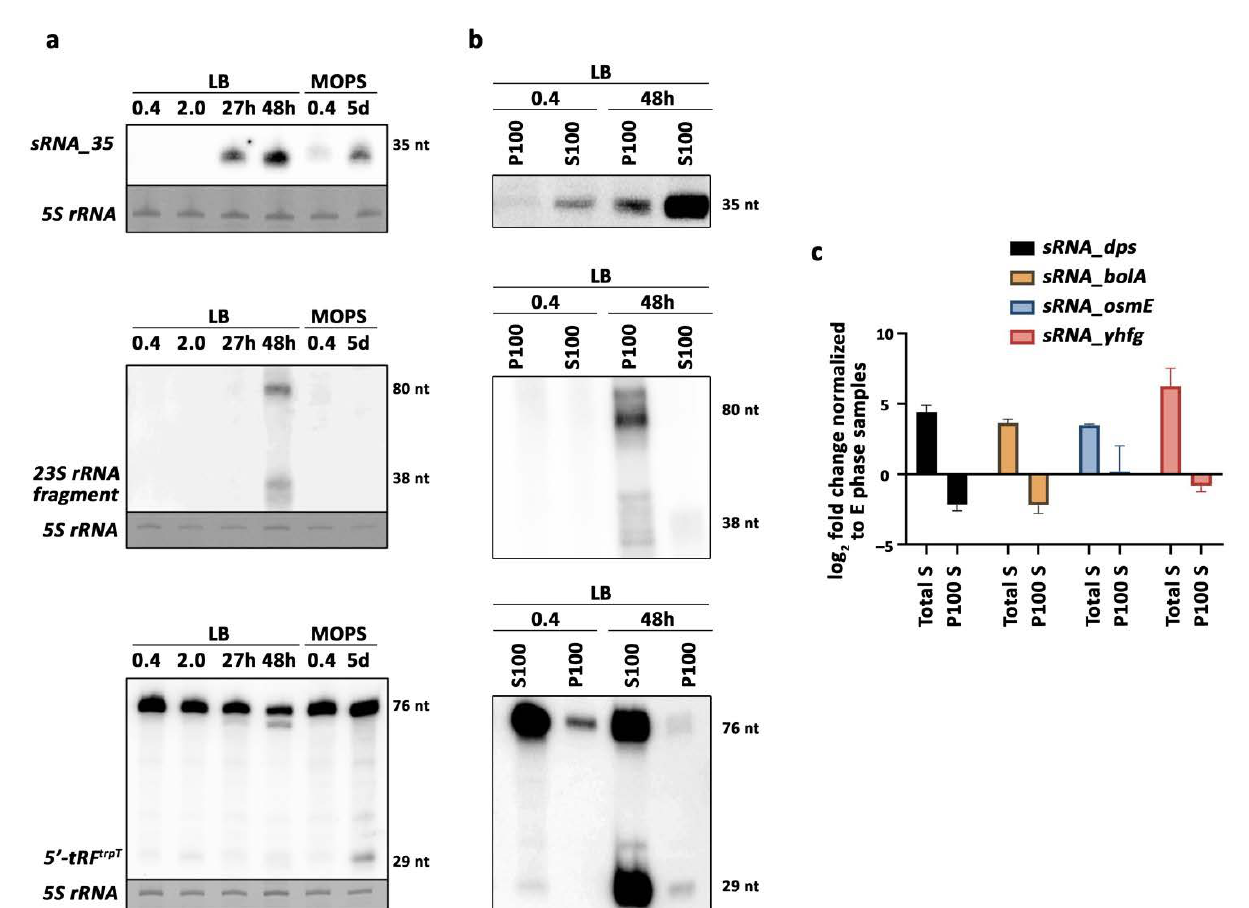
Figure 3. Validation of identified sRNAs. ( a ) Northern blot analysis of three candidates: sRNA_35 (FM_+NC_000913.2_ 4541696_34), 23S rRNA fragment (FM_+NC_000913.2_3942854_40), and 5 (cid:48) - tRF trpT (FM_+NC_000913.2_3944979_33). 5S rRNA was used as a loading control. Zero point four and 2 were optical density measurements, h = hours, d = days. tRF = tRNA derived RNA fragment. Predicted sizes are displayed on the right in nt (nucleotides). ( b ) North- ern blot analysis of candidates in A. P100 = pellet enriched for ribosome-associated RNA. S100 = supernatant con- taining non-ribosome associated RNA. ( c ) RT-qPCR mean and SEM for sRNA_dps (FM_-NC_000913.2_0848114_53), sRNA_bolA (FM_+NC_000913.2_0453657_58), sRNA_osmE (FM_-NC_000913.2_1820262_45), and sRNA_yhfg (FM_- NC_000913.2_3489623_47) in the stationary phase (two biological replicates each). log 2 fold change was based on comparison with exponential phase samples for both conditions: Total S = Total RNA samples in the stationary phase. P100 S = ribosome- associated RNA in the stationary